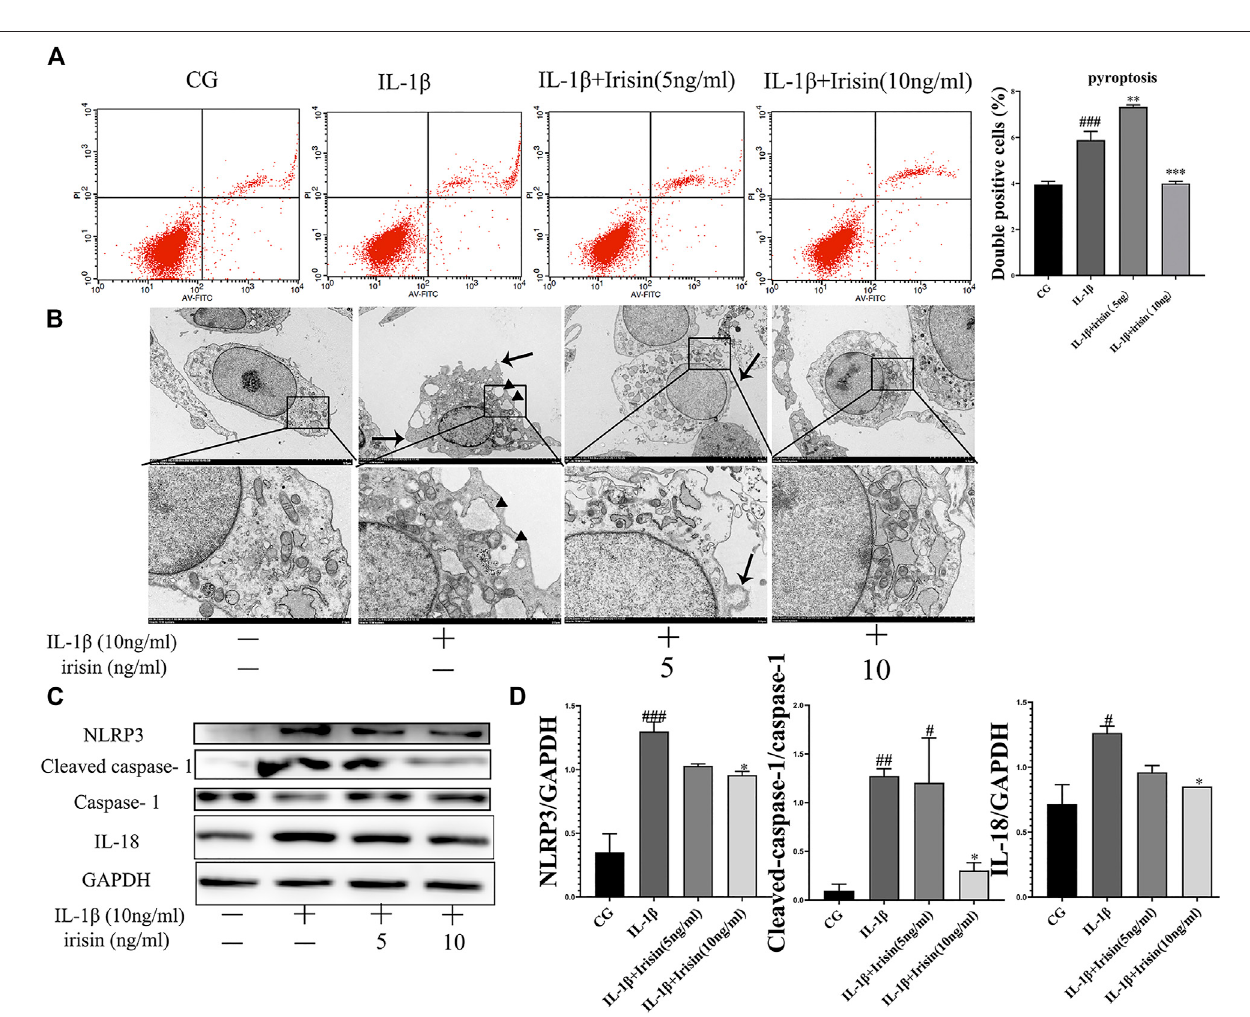
FIGURE 6 | Irisin affects IL-1 β -induced chondrocyte pyroptosis and inhibition of NLRP3/caspase-1 changes cellular morphology. (A) Effects of irisin on IL-1 β - induced chondrocyte pyroptosis. (B) Representative TEM images of cellular morphological changes, such as cell swelling, cell membrane protrusion, and cell nucleus atrophy(scalebar:5 μ m).Blackarrowsindicatecellswelling,cellmembraneprotrusion;blacktriangleindicateorganellecavitation. (C,D) Representativewesternblotsof the expression of pyroptosis-related proteins. GAPDH was used as control. Data were expressed as the mean ± SEM, * p < 0.05 vs. IL-1 β ; ** p < 0.01 vs. IL-1 β ; *** p < 0.001 vs. IL-1 β . # p < 0.05 vs. CG; ## p < 0.01 vs. CG; ### p < 0.001 vs. CG. n = 5 for each group, means ±95% CI.